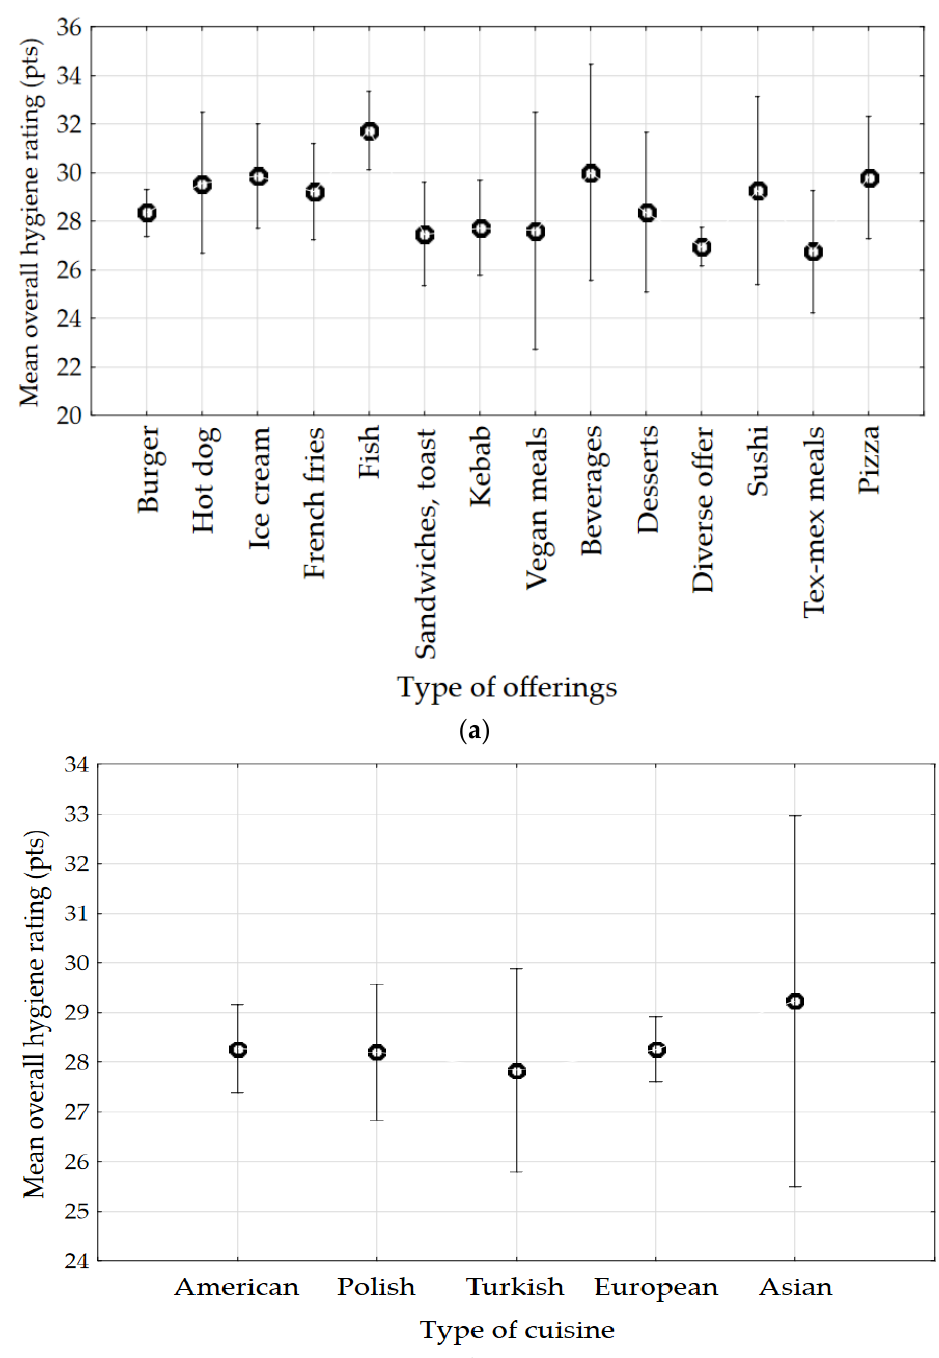
Figure 2. Overall hygiene rating according to: ( a ) type of offerings, ( b ) type of cuisine (bars are standard deviation